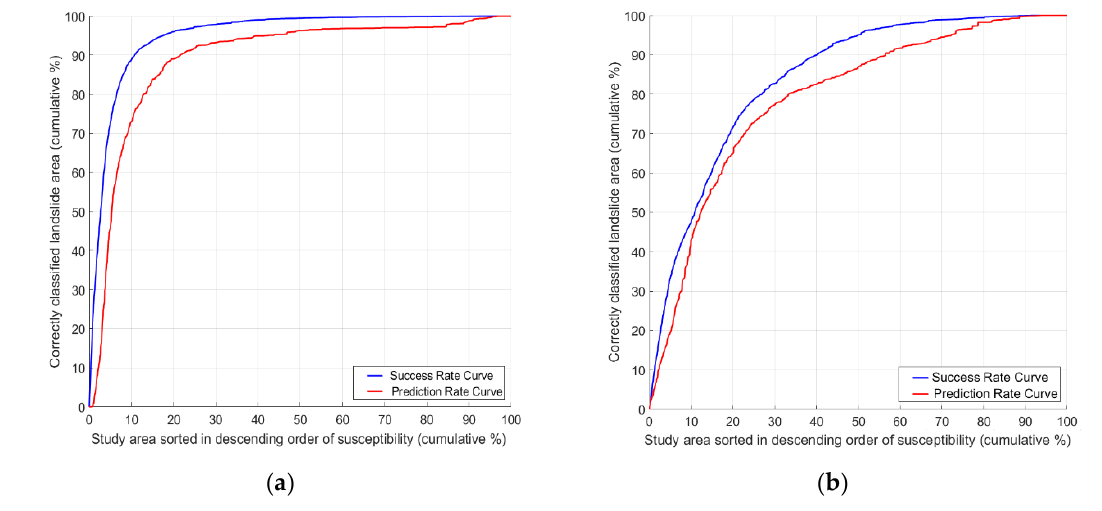
Figure 10. Success and Prediction Rate Curves for the best landslide susceptibility models, developed for: ( a ) falls and ( b ) slides.